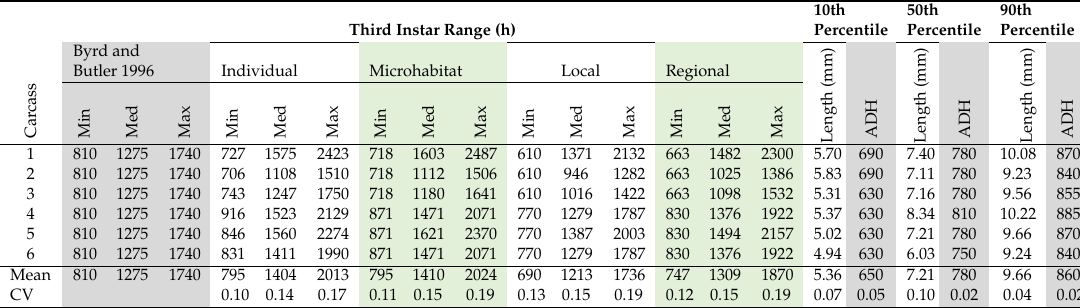
Table 1. Actual and expected minimum (Min), median (Med), and maximum (Max) accumulated degree hours (ADH) associated with Cochliomyia macellaria development, using a minimum developmental threshold of 10 ◦ C, based on third instar range (time present on carcasses) and body lengths representing the 10th, 50th, and 90th percentiles. White and green areas represent actual values while gray areas represent expected values [30].